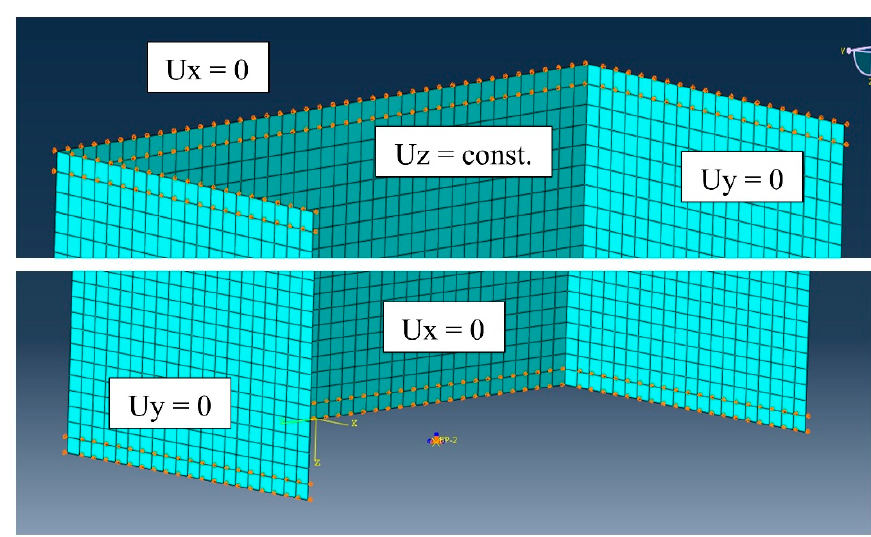
Figure 7. Upper-end and bottom-end boundary conditions of the GFRP strut.